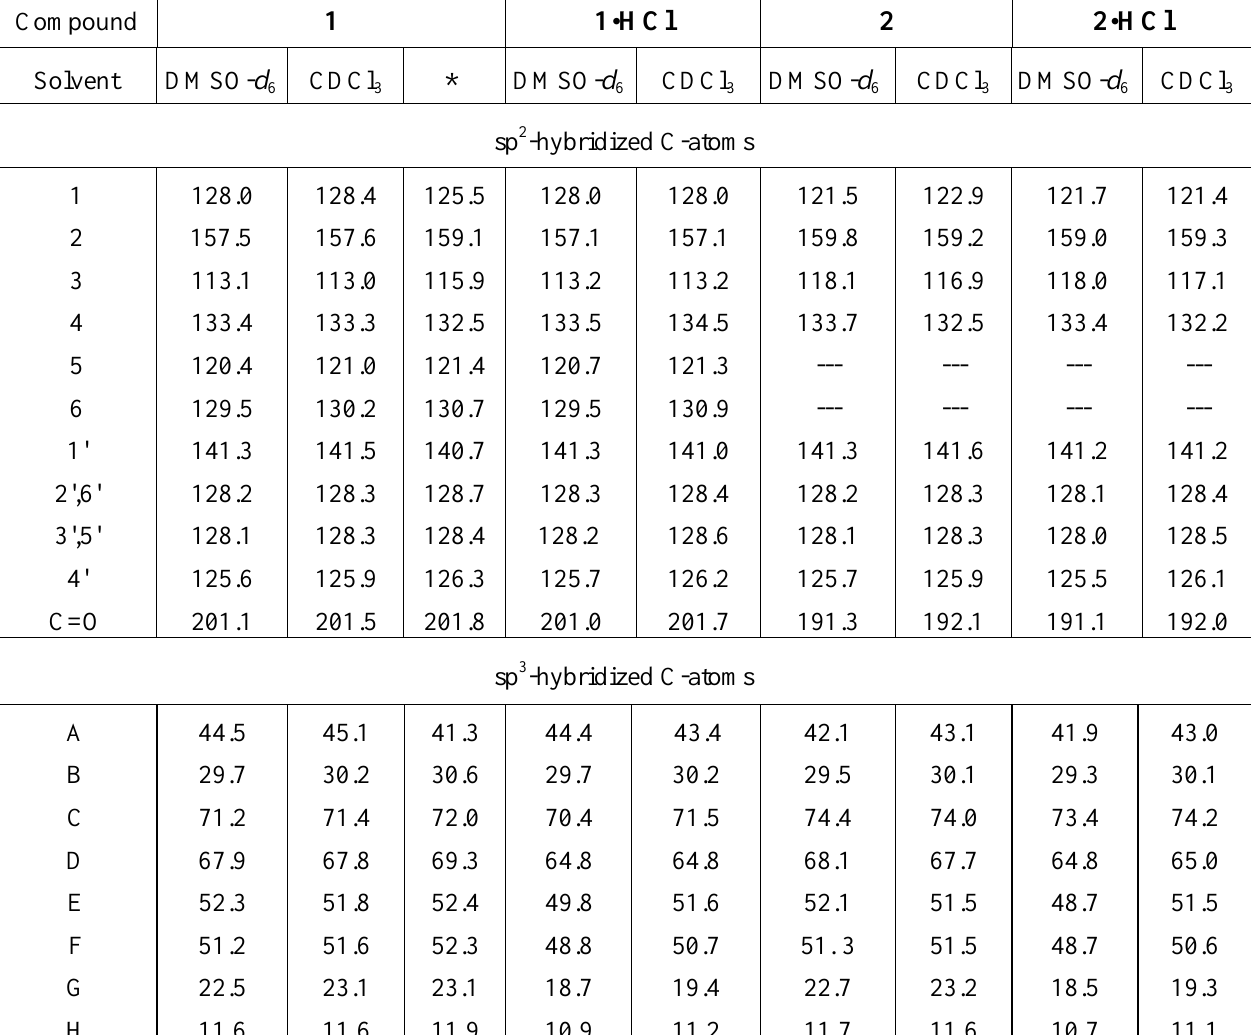
Table 2 : 13 C-NMR Chemical Shifts and Selected 13 C, 1 H Coupling